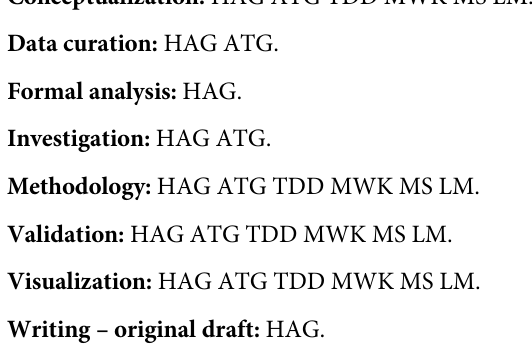
S2 Table. Assessment of methodological quality (n = 9). It shows the result of the methodo- logical quality